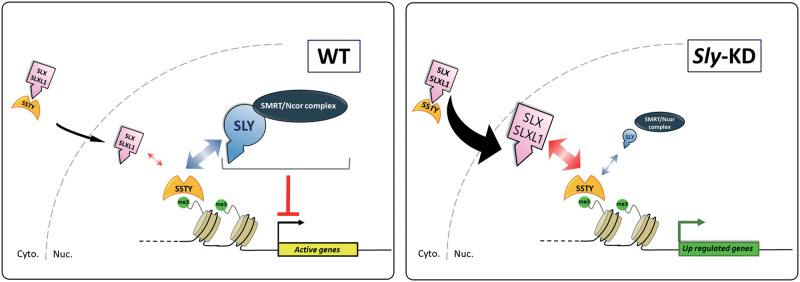
Working model: competition between SLX/SLXL1 and SLY for partner interaction and chromatin occupancy drives multicopy gene expression in mouse spermatids. SSTY proteins bind to H3K4me3-enriched TSS of expressed (active) genes in spermatids, in particular of multicopy spermatid-specific genes such as Slx/Sly, Ssty, Mgclh, H2al, and Samt genes on the sex chromosomes, or Speer/Takusan genes on autosomes. In WT spermatids (left panel), SLX/SLXL1 and SLY proteins compete for interaction with SSTY in the cytoplasm and in the nucleus. With SLX/SLXL1 being predominantly cytoplasmic, SLY occupies most of SSTY-bound TSS. SLY recruits SMRT/N-Cor repressive transcriptional complex which restrains (but does not switch off) the expression of multicopy genes. When Sly is knocked down (right panel), Slx/Slxl1 genes are upregulated and SLX/SLXL1 protein level in the nuclei is higher. SLX/SLXL1 proteins are now the main partners of SSTY and, most of SSTY-bound TSS are devoid of SLY and occupied by SLX/SLXL1 proteins. As SMRT/N-Cor protein complex preferentially interacts with SLY but not with SLX/SLXL1, SMRT/N-Cor recruitment at these TSS is diminished, which leads to upregulation of target genes.